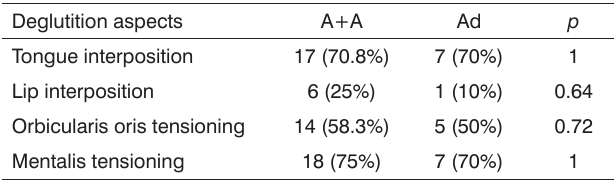
Table 2. Comparison of frequencies of occurrence of deglutition aspects in children with adenotonsillar hypertrophy (group A+A) and children with adenoid hypertrophy (group Ad) based on Fisher’s exact